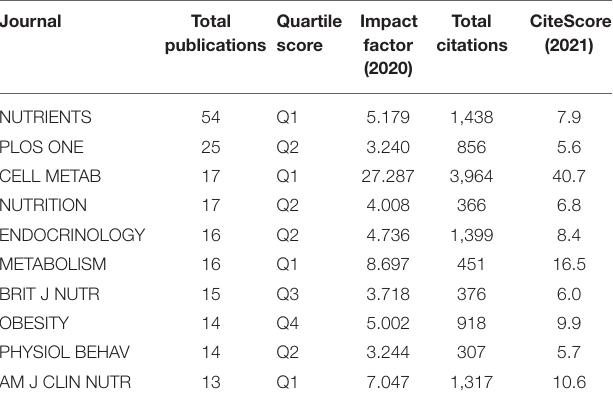
TABLE 4 | Top 10 journals with the most published articles.